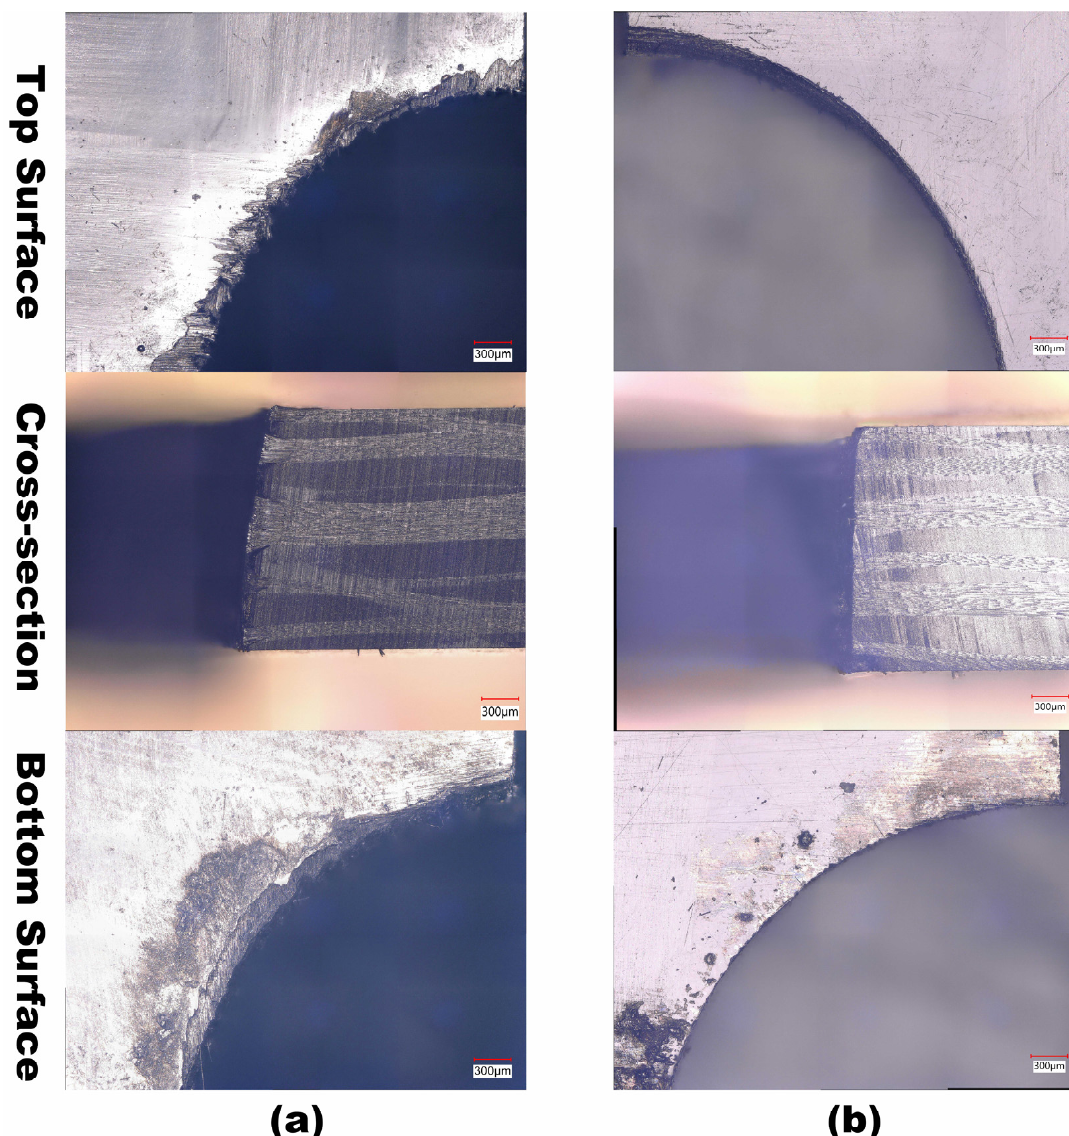
Figure 16. Comparison of hole quality: ( a ) laser drilled pilot hole; ( b ) mechanical finished hole.